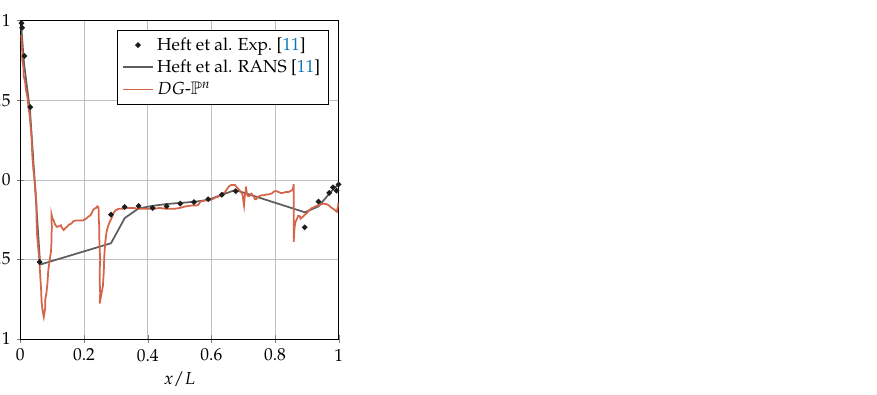
Figure 15. DrivAer model—Time-averaged pressure coefficient distribution on the z = 0.06 plane.